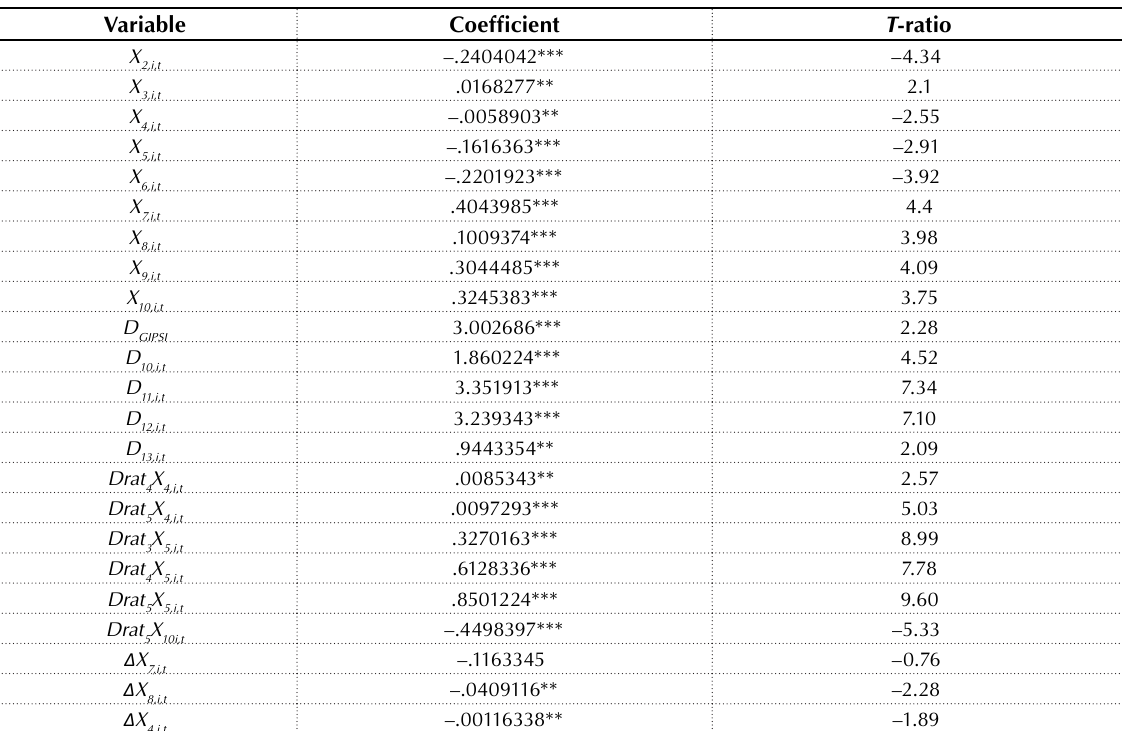
Table A2. Estimation results: panel ordered